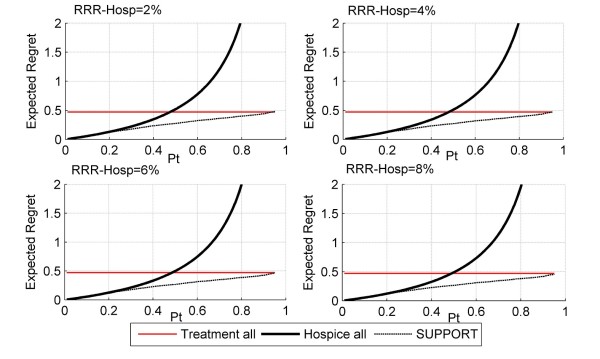
Decision curves as a function of RRRHosp. In this figure, RRRHosp = 2% to 8%, RRRRx = 0, HRx = HHosp = Hte = 0. As the effect of hospice care increases, the regret associated with hospice and with the SUPPORT model slightly decreases. As previously, the strategy of using the SUPPORT model to refer a patient to hospice is the action with the least amount of regret for a wide range of threshold probabilities.